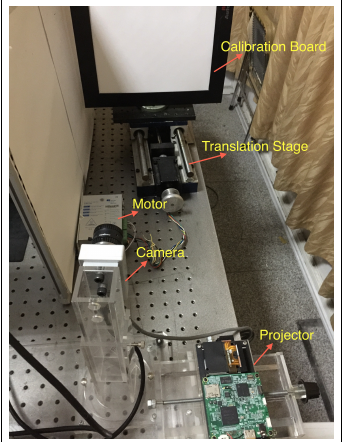
Figure 3. Experimental setup of the fringe projection vision system: Fringe patterns are projected by the projector. The deformed fringe patterns are captured by the camera. The system calibration is implemented with the help of the calibration